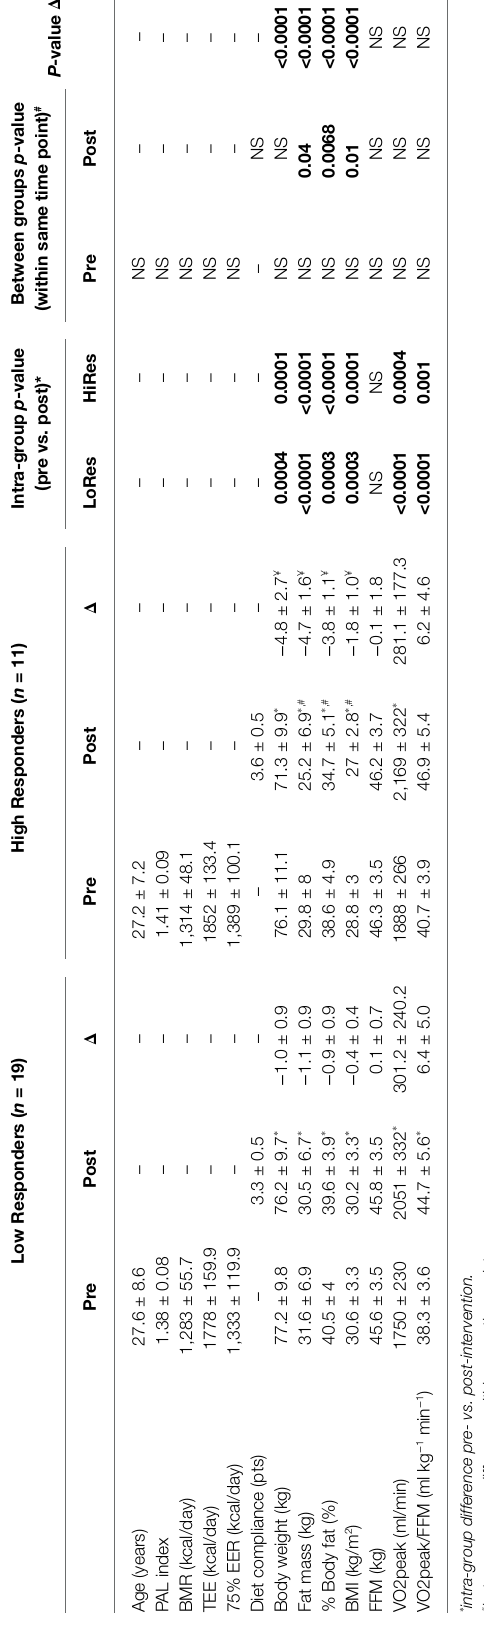
HiRes groups, and a reduction of systolic blood pressure only in the LoRes group (110.9 ± 8.4 vs. 104.7 ± 9.1 mmHg; p = 0.03; Table 2 ). Importantly, all these changes occurred, although none of the study participants had arterial hypertension. About metabolic parameters, no differences were found in fasting glycemia, but there was an inter-group difference in blood fasting insulin after the intervention, where the LoRes group showed higher values than the HiRes group (11.9 ± 2.3 vs. 9.4 ± 2.2.2 μ U/dl; p = 0.04; Table 2 ). Genotypes distribution and relative frequency of alleles for PLIN1 rs1052700, PLIN1 rs2304795, LPL rs283, and ADRB3 rs4994 gene polymorphisms are shown in Table 3 . All polymorphisms evaluated were in Hardy-Weinberg equilibrium ( Table 3 ).